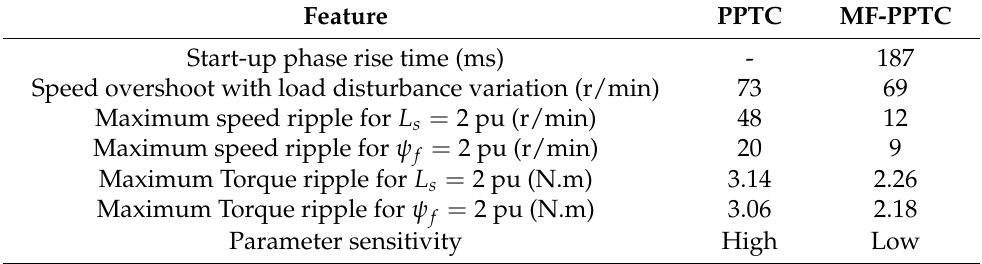
Table 3. Performance